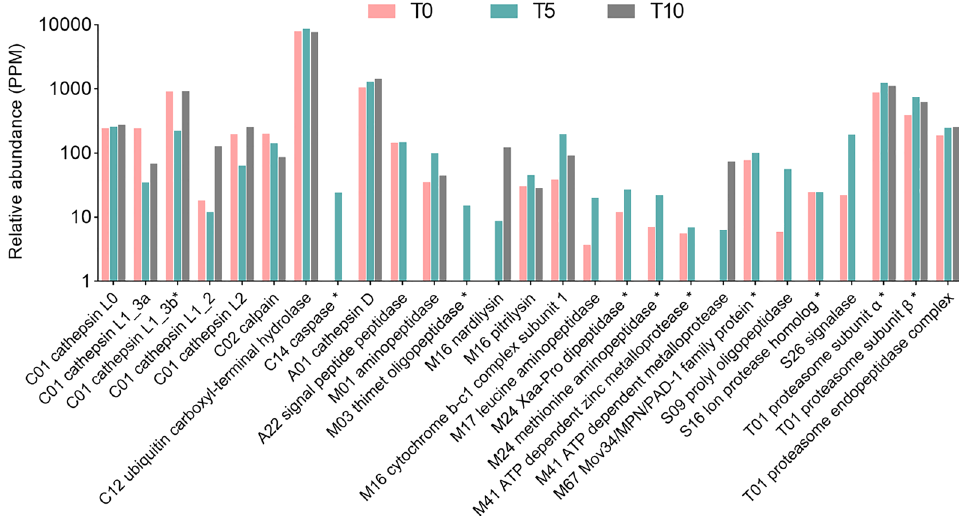
Figure 3. Relative abundances of peptidases identified by LC–MS/MS. Relative abundance values (PPM) are shown on the logarithmic scale. Different isoforms of signalase, proteasome subunit α, proteasome subunit β, and proteasome endopeptidase complex are presented as single columns. Peptidases marked by an asterisk (n = 10) were significantly differentially expressed. Cathepsin L isoforms were named according to Cwiklinski et al. 50 nomenclature.